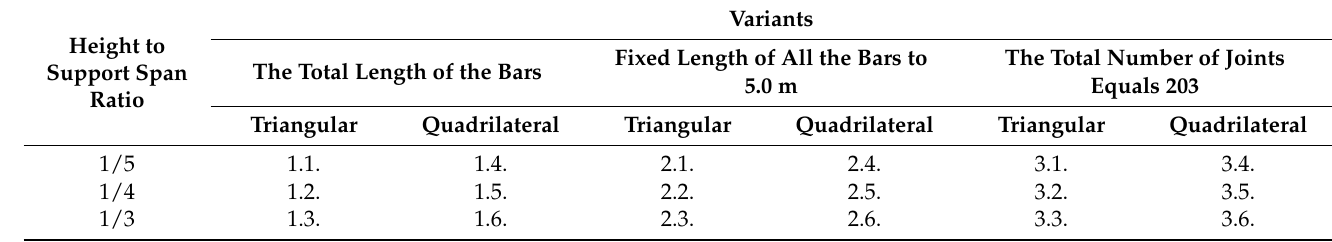
Table 2. The variants of Study 2.